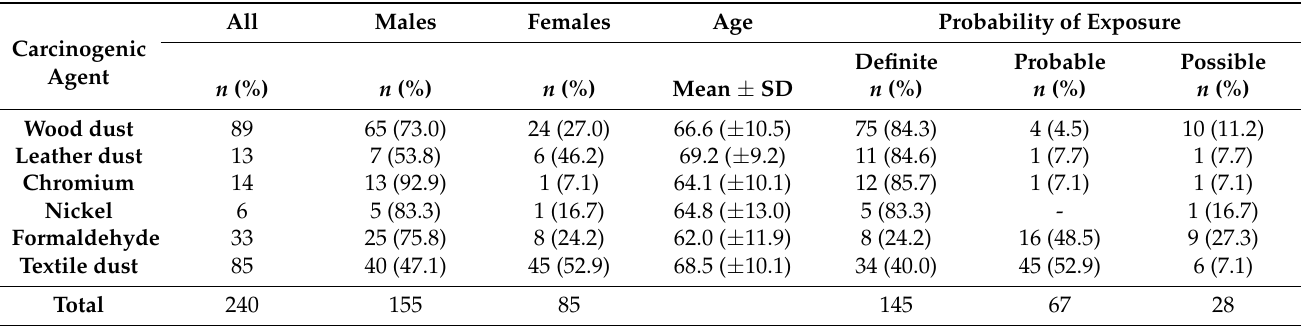
Table 1. Exposures to IARC carcinogenic agents for nasal cavities and paranasal sinuses ( n , %) by gender, age, and exposure evaluation.